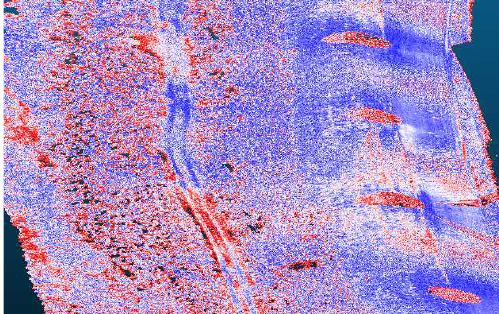
Figure 10: Zoom on a the comparison between the FraserBasic model and the first Lidar